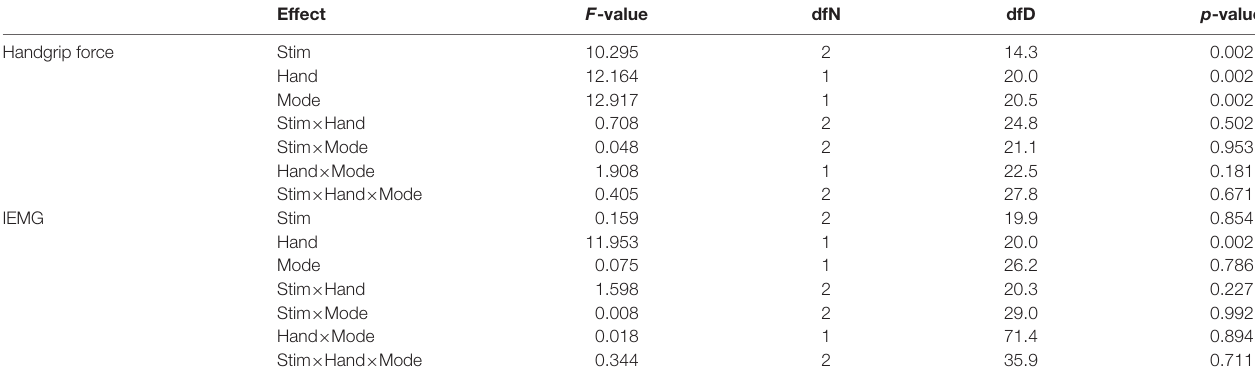
TABLE 1 | Summary of linear mixed-effects model analysis of variance.